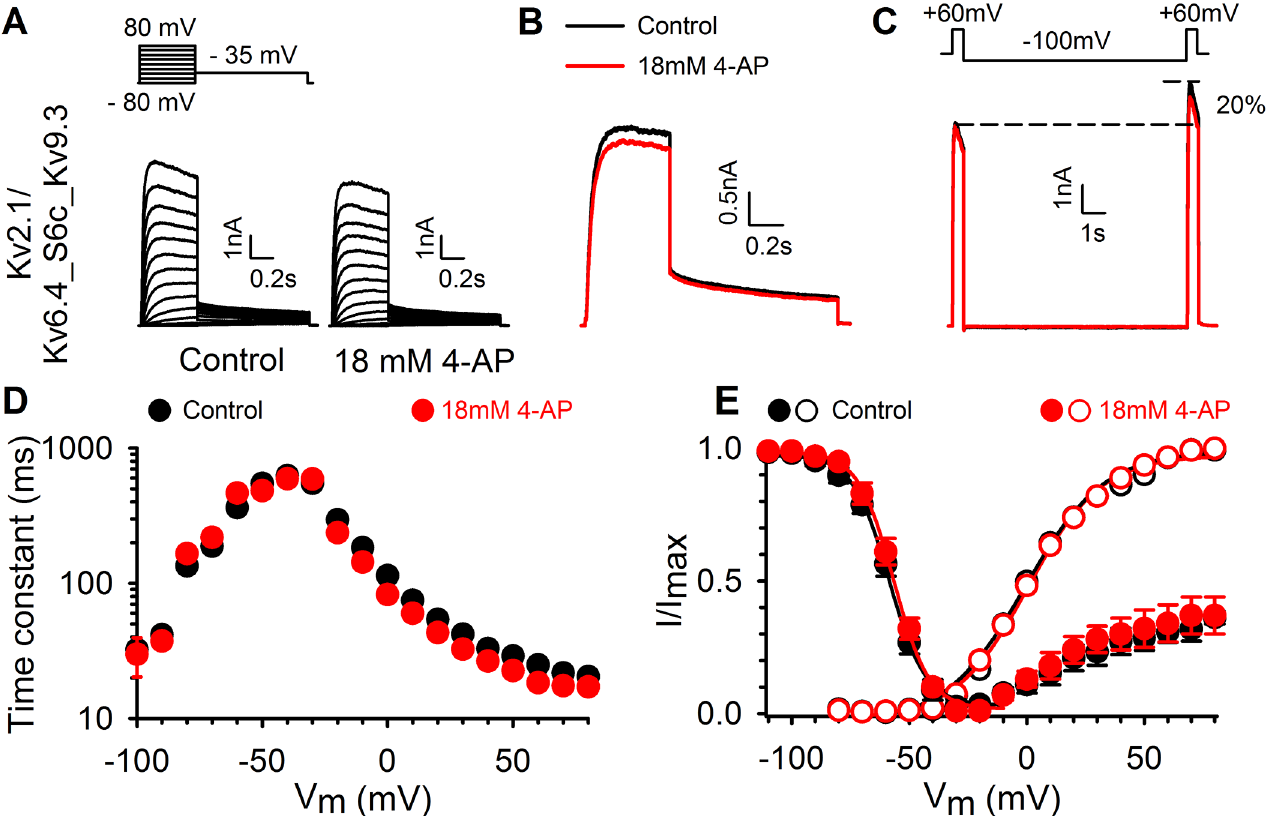
Fig 6. Involvement of the S6c domain in the KvS specific response to 4 − AP. (A) Typical current traces for the Kv2.1/Kv6.4_S6c_Kv9.3 chimera without (left) and with 4 − AP (right) revealing inhibition by 4 − AP, comparable to its effect on Kv2.1/Kv9.3_WT currents. The pulse protocol is shown above the current traces. (B) 4 − AP (red trace) causes a small inhibiting effect of Kv2.1/Kv6.4_S6c_Kv9.3 currents which is the opposite of the 4 − AP effect on the Kv2.1/ Kv6.4_WT currents. Control trace shown in black. (C) The twin pulse protocol from Fig 4E was repeated on the Kv6.4_S6c_Kv9.3 chimera to illustrate that: 1) closed − state inactivation is still present at − 80mV, 2) inactivated channels can be recovered in a 10s pulse to − 100 mV and 3) 4 − AP is unable to interfere with the closed − state inactivation of the Kv6.4_S6c_Kv9.3 chimera. (D) Activation and deactivation kinetics of the Kv2.1/Kv6.4_S6c_Kv9.3 heterotetramers (black circles). Time constants of the chimera were obtained with a single exponential function which resulted in a single fast component that remained unaltered under the influence of 4 − AP (red circles). This chimera lacked the pronounced slow component present in Kv2.1/Kv6.4_WT heterotetramers (Fig 3C). (E) Voltage − dependence of activation (open symbols) and inactivation (closed symbols) of the Kv2.1/Kv6.4_S6c_Kv9.3 chimera obtained like for the WT Kv2.1/Kv6.4 heterotetramers in Fig 3. Both were nearly the same as for WT Kv2.1/Kv6.4 currents and remained unaffected by 4 − AP application (red